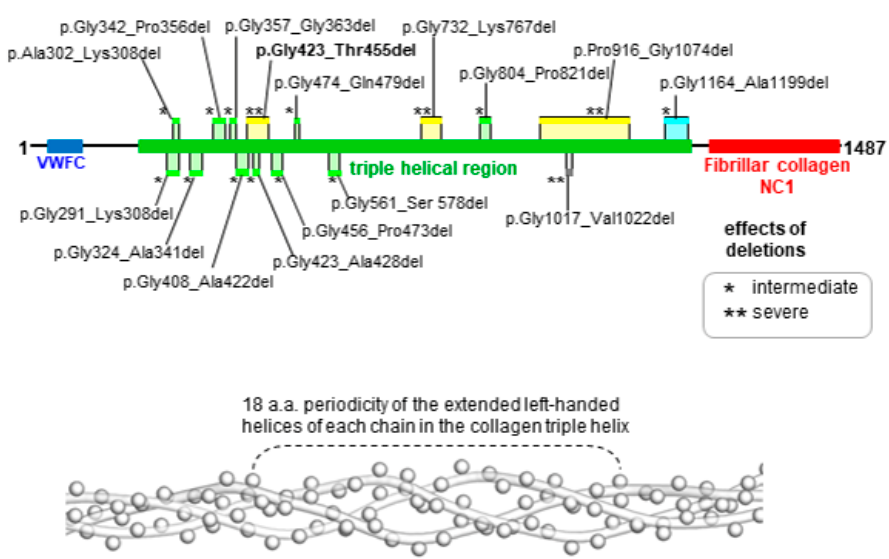
Figure 4. Schematic view of collagen α -1(II) chain (top) that shows the novel protein deletion position reported in this work and previously published deletions. Deletions, characterized by the loss of 18 amino acids or fewer, causing intermediate (*) and severe (**) effects are shown in light green and grey, respectively. Larger deletions causing intermediate (*) and se- vere (**) effects are shown in light blue and yellow, respectively. In the severe group, there are cases of ACG2 or hypochondrogenesis. In the intermediate group, there are cases of Kni- est dysplasia or SEDC. Periodicity of 18 amino acids (bottom) of the extended left-handed helix of each protein chain in the collagen triple helix are exemplified here by a portion of the Pro- tein Data Bank structure 3HQV (C α atoms are represented by spheres). Amino acid numbering refers to the protein with NCBI accession code NP_001835.3. p.Gly423_Thr455del (our